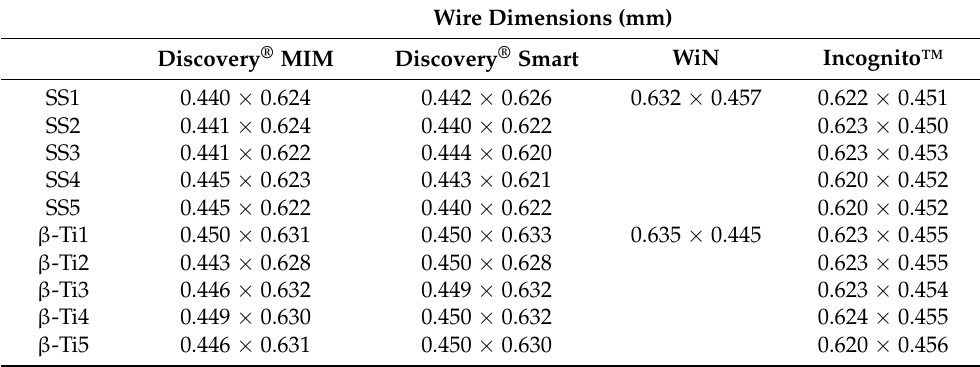
Table 3. Measured dimensions of the selected wires. The nominal dimensions are 0.635 × 0.462